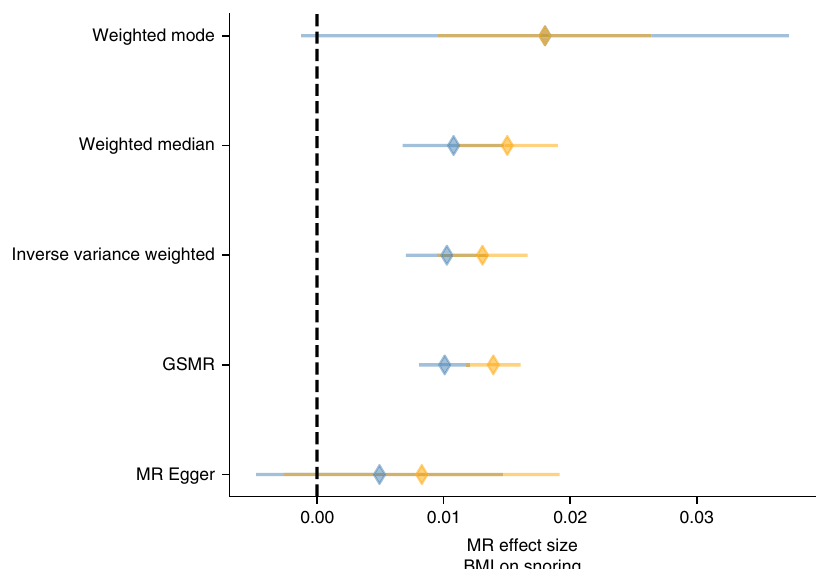
Fig. 5 Assessing the causal relationship between BMI and snoring. Forest plot showing Mendelian randomization results testing for causal relationships between BMI and snoring. Blue markers represent the estimate between the exposure effect sizes (female-only GWAS) and assessing its causal relationship on snoring (male-only GWAS). Yellow markers show the exposure effect sizes (male-only GWAS) assessing its causal relationship on snoring (female-only GWAS). Diamonds represent the effect size and error bars represent the 95% con fi dence